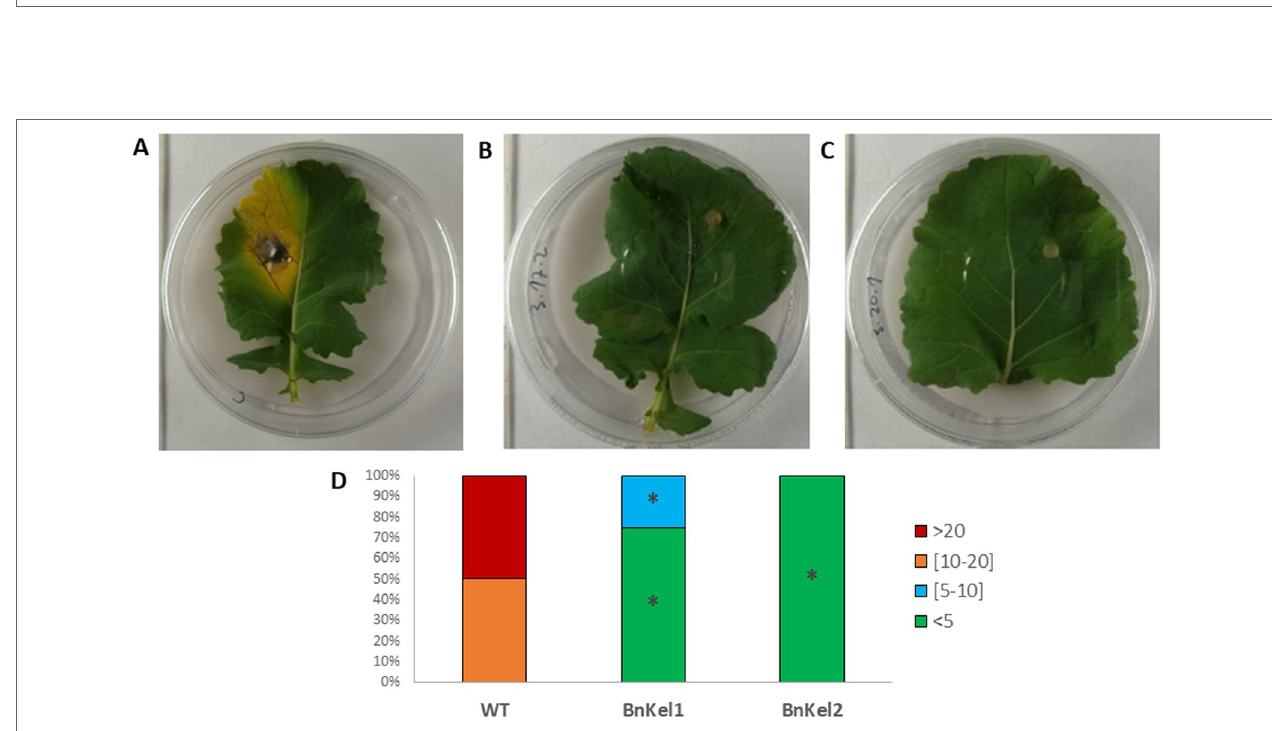
FIgURE 2 | Rapeseed leaf lesions caused by P. lingam . Commercial variety (WT) (a) and transgenic lines BnKel1 and BnKel2 (B and C) , 7 days after pathogen inoculation. The quantification of the lesions produced (D) has been represented by columns that show the percentages of the diameter (mm) lesion groups of the lesions. Data were obtained from three biological replicates, and five plants per replicate for each condition. Asterisks denote significant differences at P ≤ 0.05 using the non-parametric Friedman’s test.